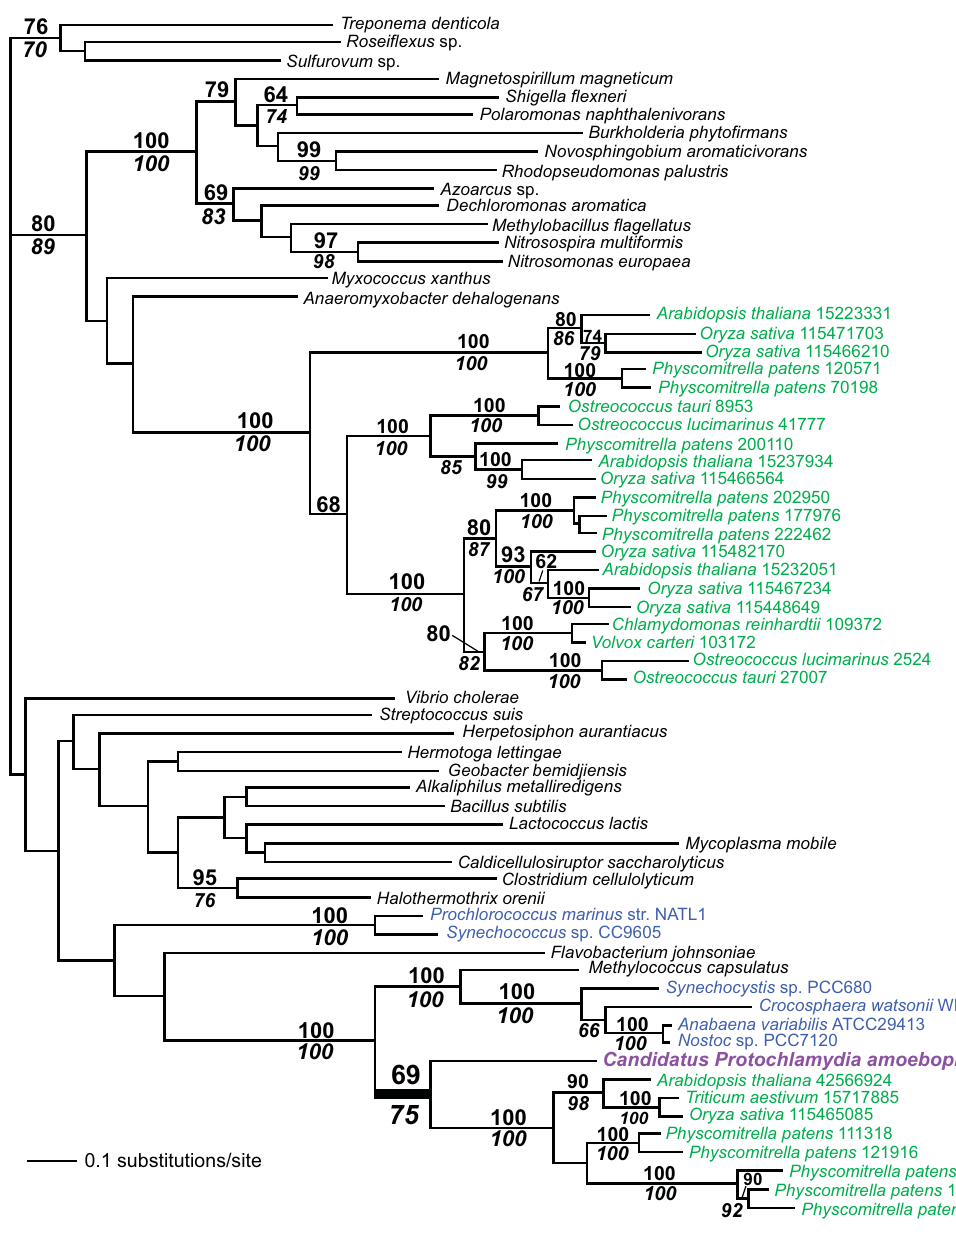
Figure 3. Maximum likelihood (RAxML) tree of the Chlamydiae-derived Plantae protein, glycogen synthase. The results of a bootstrap analysis using RAxML are shown above the branches, whereas PHYML bootstrap support values are shown below the branches. Only bootstrap values $ 60% are shown. Branch lengths are proportional to the number of substitutions per site (see scale bar). Cyanobacteria are shown in blue text, green algae and land plants in green text, and Chamydiae in magenta. All other bacteria are shown in black text. The thick branches unite Chlamydiae and Plantae.